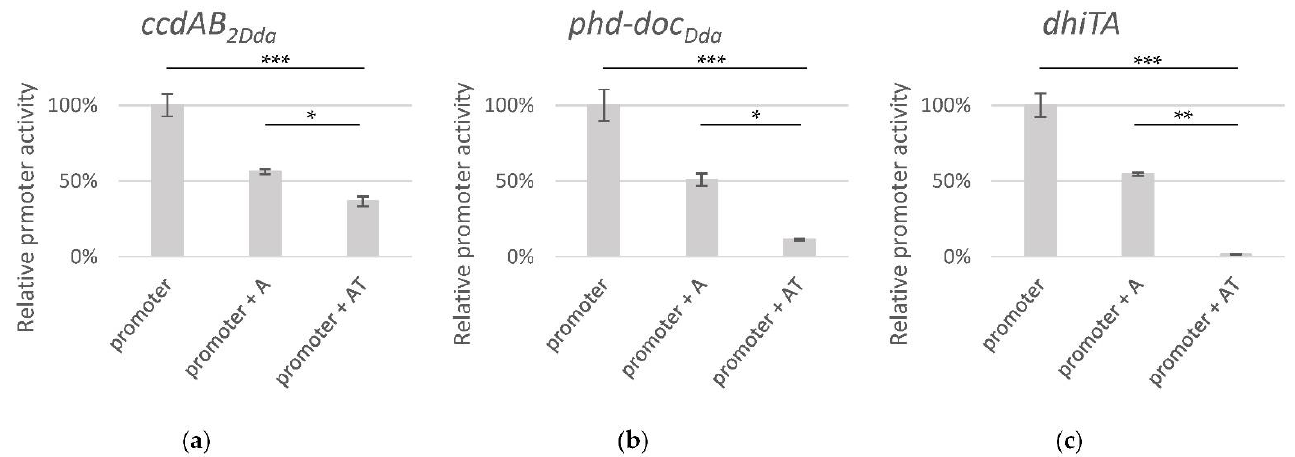
Figure 7. The antitoxin or toxin-antitoxin complex autoregulates the TA operon. ( a ) ccdAD 2Dda system, ( b ) phd-doc Dda system, ( c ) dhiTA system. The pBBRlux plasmid derivatives harbouring transcriptional fusions of promoter regions of different TA operons to the promoter-less luxCDABE reporter operon and pBAD24 derivatives harbouring antitoxin or antitoxin-toxin encoding genes were co-transformed into E. coli and grown under inducing conditions for 3 h (to the late exponential phase, OD 600 ~1.0). Luminescence in RLU (relative light units) was measured. E. coli harbouring promoter-less pBBRlux and non-recombinant pBAD24 was used as the negative control. The results represent an average of at least three independent experiments and are shown as a percentage of uninhibited promoter activity, where 100% value corresponds to ( a ) 61,579 +/− 4571 RLU, ( b ) 443 +/− 46 RLU or ( c ) 46,438 +/− 3613 RLU and to 31 +/− 1 RLU for a negative control. * p < 0.05, ** p < 0.01, *** p < 0.001, using ANOVA.